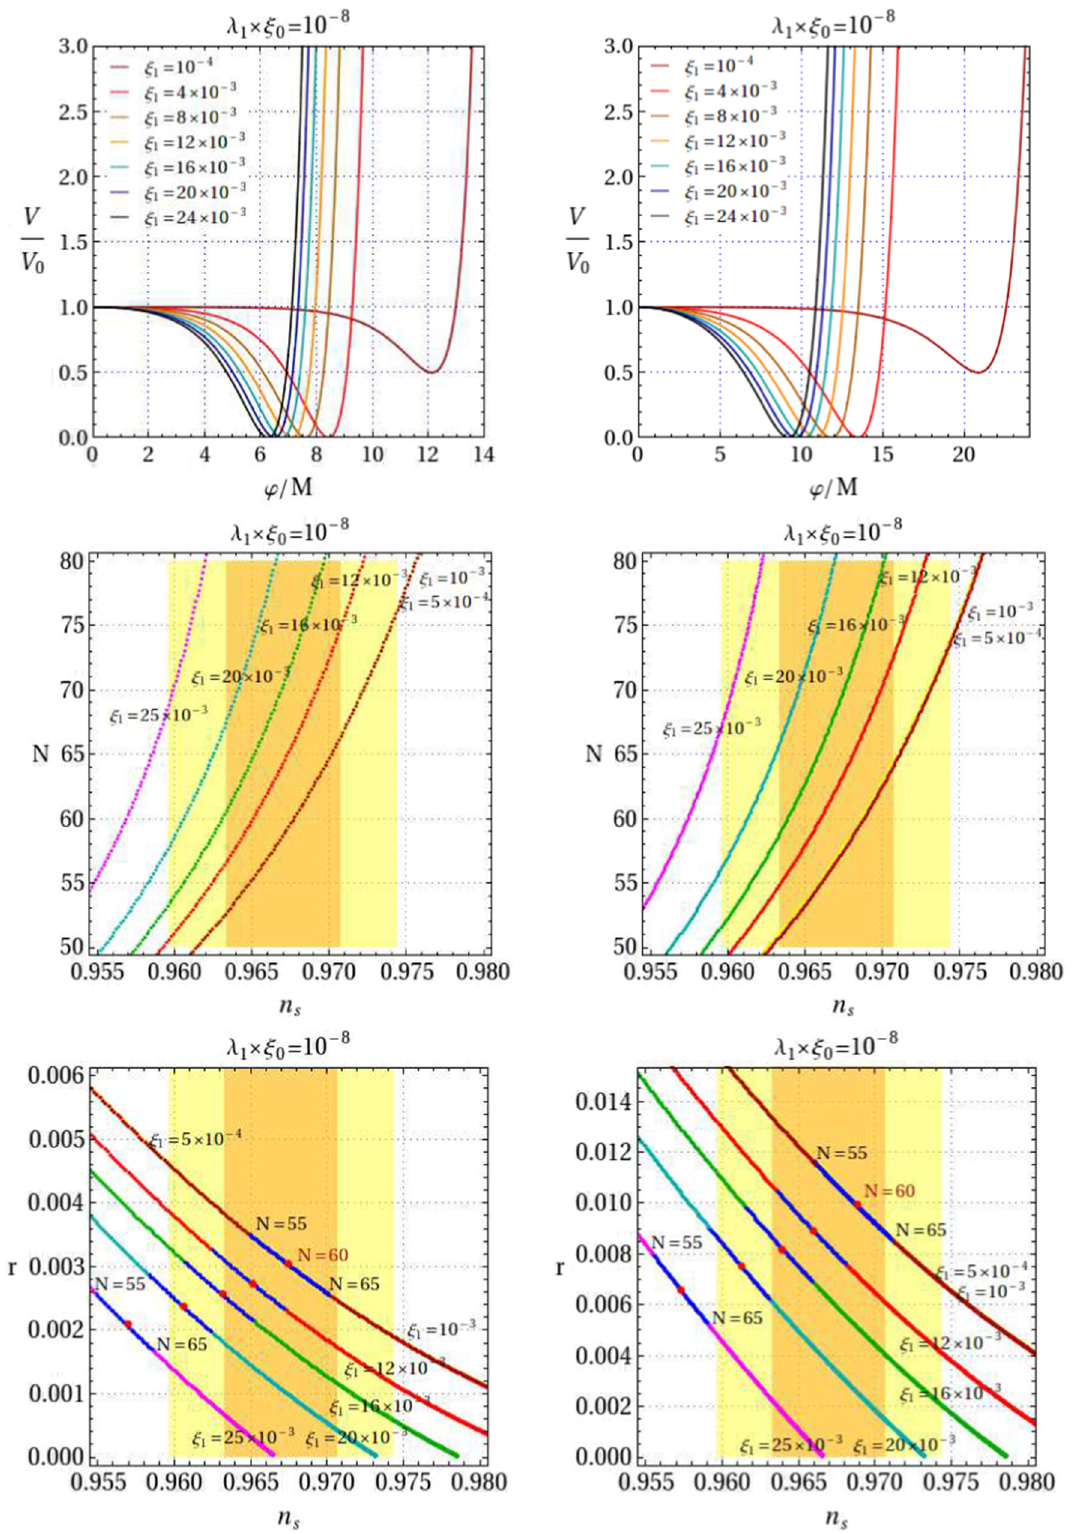
Fig. 1 Left column: Weyl inflation plots; Right column: Palatini infla- the plots ( n s , r ) for different ξ 1 ; curves of ξ 1 = 5 × 10 − 4 and 10 − 3 tion plots. All figures have λ 1 ξ 0 = 10 − 8 ≤ ξ 2 ; Top plots: the potential are degenerate; along these curves the value of N changes: the blue 1 V / V 0 in terms of ϕ/ M for different ξ 1 ; larger ξ 1 moves the curves line segment has points of 55 ≤ N ≤ 65; red dots have N = 60. The yellow (orange) area corresponds to the measured value of n s at 95% to the left; larger λ 1 ξ 0 lifts the minimum of the rightmost curves, see Eq. (17); middle plots: the plots ( n s , N ) for different ξ 1 ; bottom plots: CL ( 68% ) ,